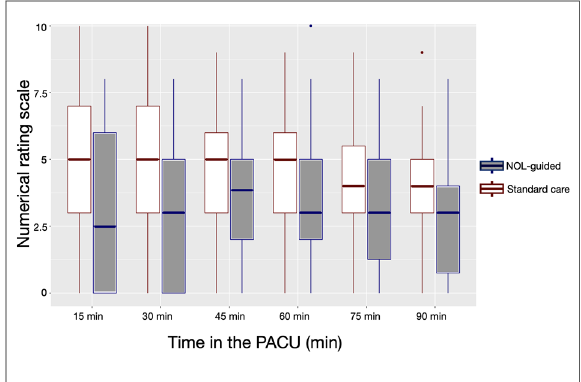
FIGURE 2 ( A ). Boxplot of the individual median pain scores observed during the patients ’ stay in the PACU. ( B ). Percentage of patients with mild pain (NRS<4), moderate pain (NRS>4 and<7) and severe